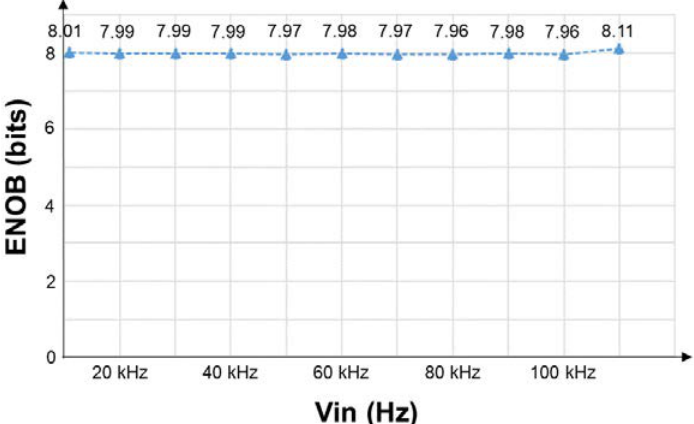
Figure 19. Measured ENOBs with respect to the input frequency from 10 kHz to 110 kHz at the sampling frequency of 0.909 MS/s.